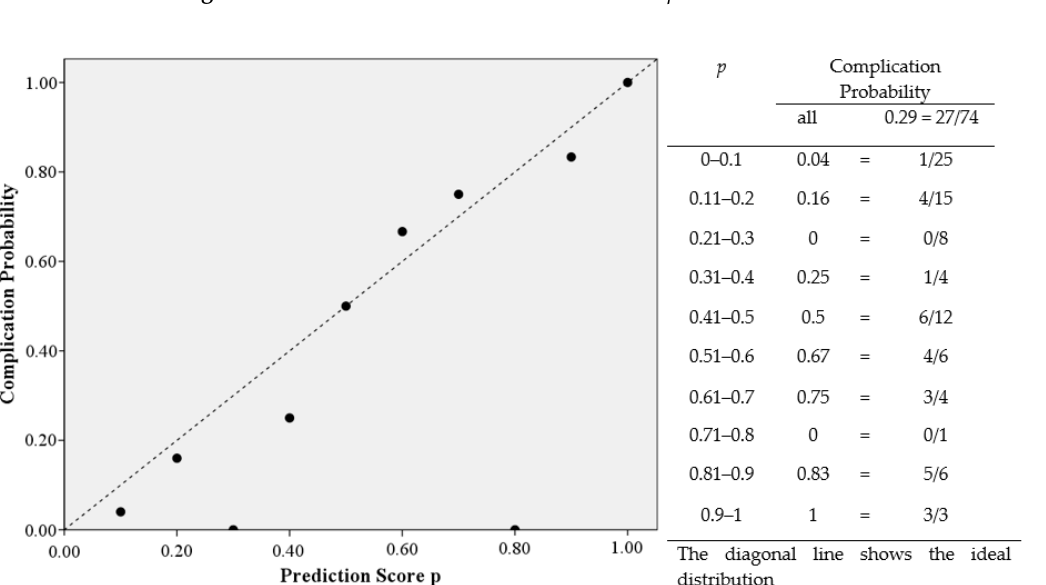
Figure 1. The Calculation of the Prediction Score p.